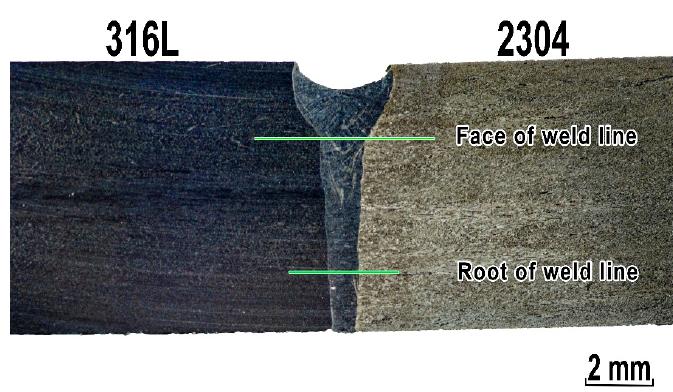
Figure 5. Cross ‐ section of the 316L–2304 stainless steel welded joint. The arrangement of microhardness measurement points on the specimen is marked by lines.